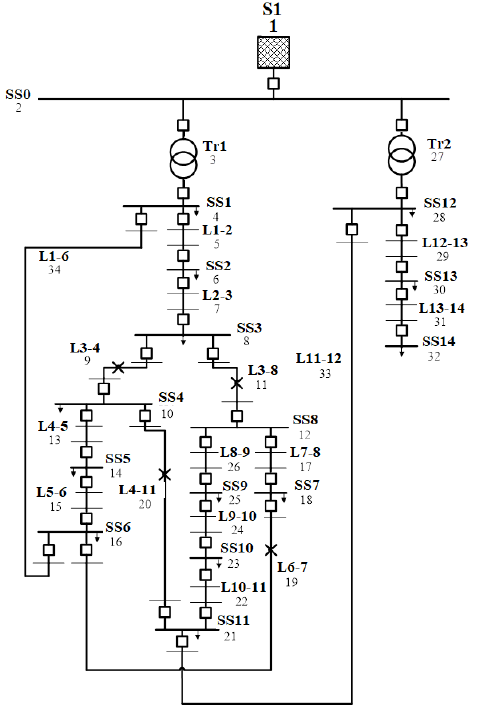
Figure 4. Structure 2 of the distribution network.